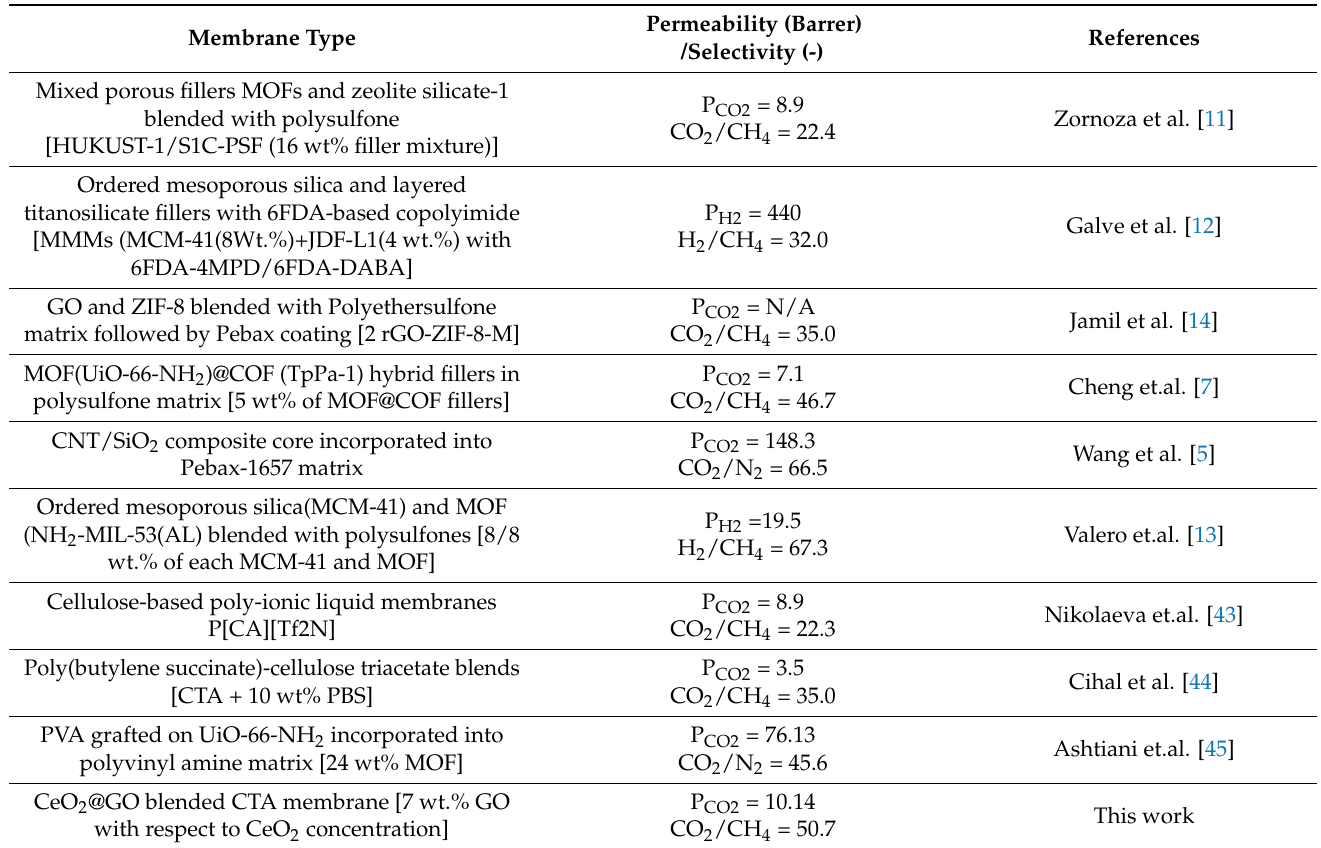
Table 3. Gas separation performance of the reported MMMs in comparison with this